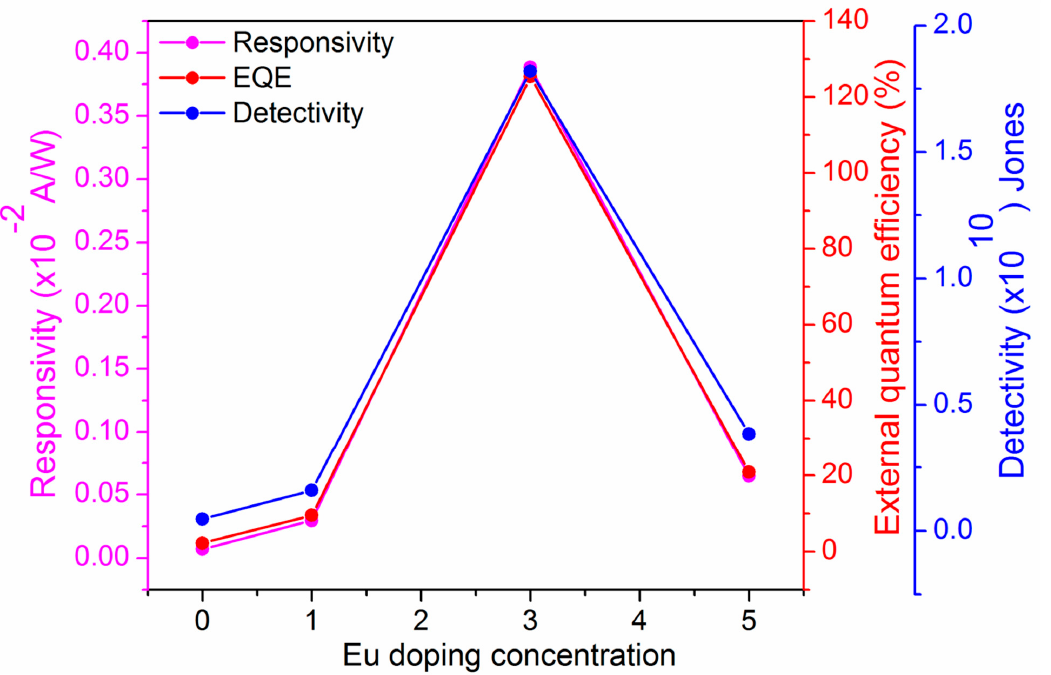
Figure 8. Responsivity, detectivity, and external quantum efficiency of the Eu-doped Bi 2 S 3 photosensor, with Eu doping concentrations.